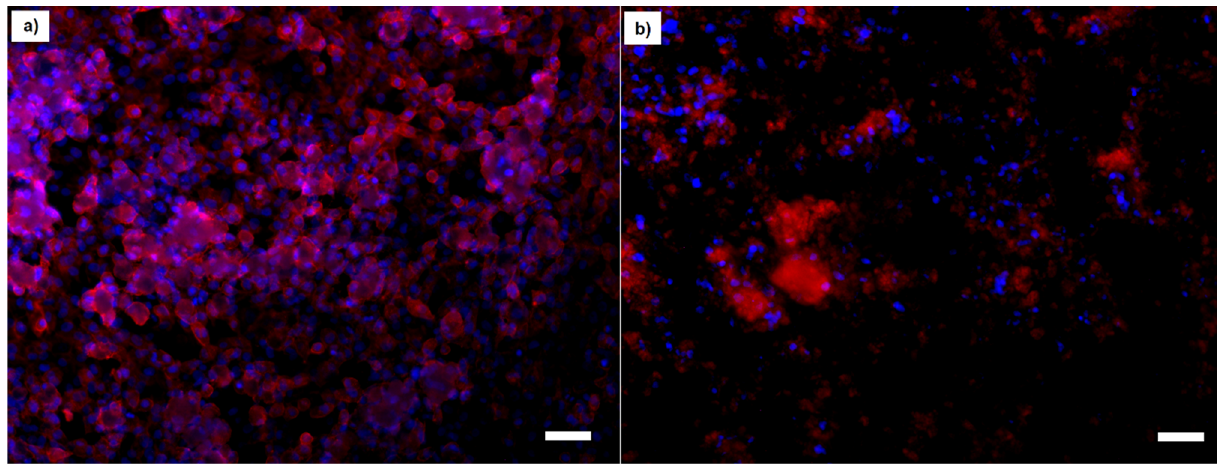
Molecules 2021 , 26 , x FOR PEER REVIEW Figure 10. Fluorescence microscopy micrographs of MG-63 cells treated with ( a ) composite microspheres at 50:50 (PHBV/MBGN) ratio and ( b ) same proportion of free MBGN, after seven days of incubation (bar size is 20 mm).